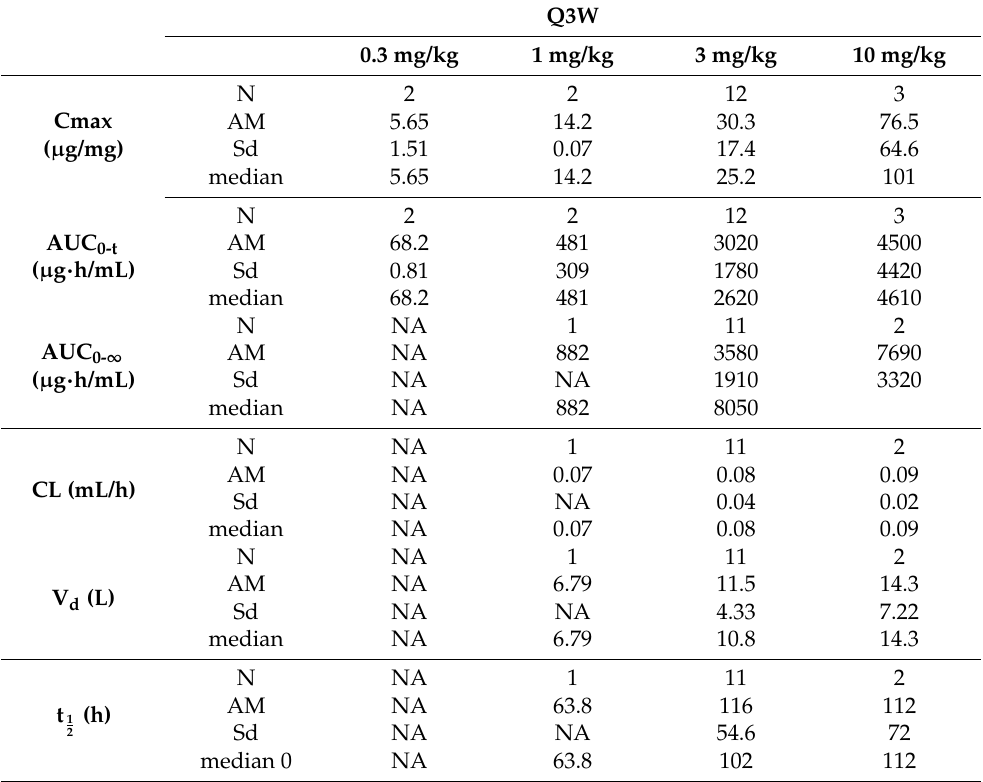
Table 3. Pharmacokinetics of ARGX-111 at cycle 1 after the first ARGX-111 administration (actual time points).